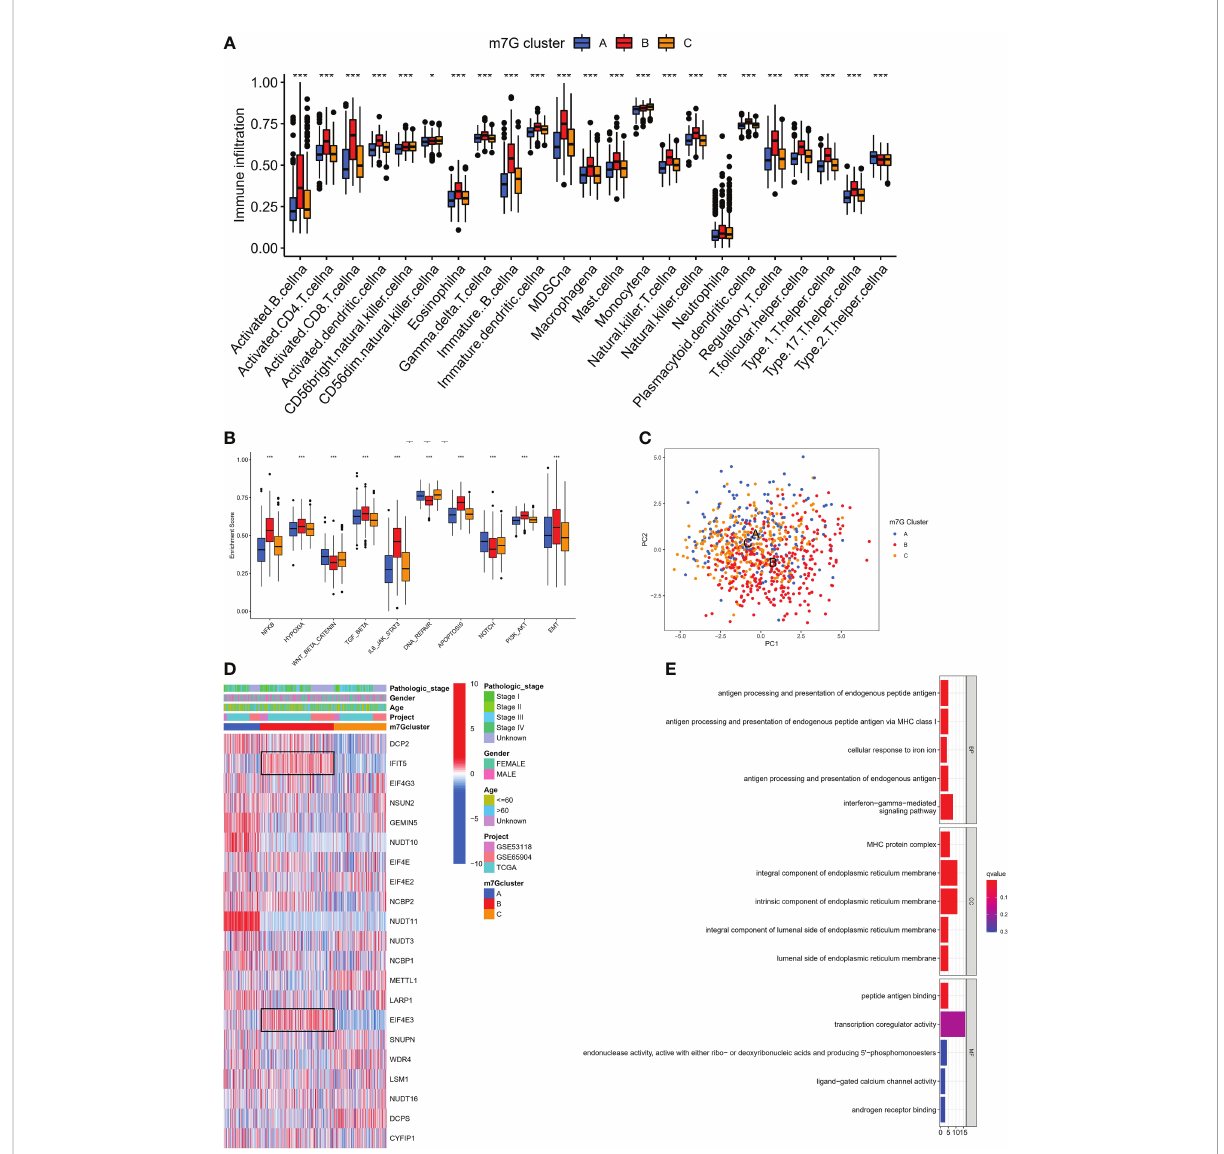
FIGURE 3 The characteristics of TME in distinct m7G clusters. (A) The in fi ltration level of immune cells in three m7G clusters. (*p < 0.05; **p < 0.01; ***p < 0.001). (B) GSVA enrichment analysis based on Hallmark gene set according to different m7G clusters. (***p < 0.001). (C) Principal component analysis based on pathway activity score corresponding to m7G clusters. (D) Unsupervised clustering of gene expression of 21 m7G genes in the meta-SKCM cohort.M7G cluster, pathologic stage, gender, and age were used as annotations. (E) GO enrichment analysis of prognosis-related